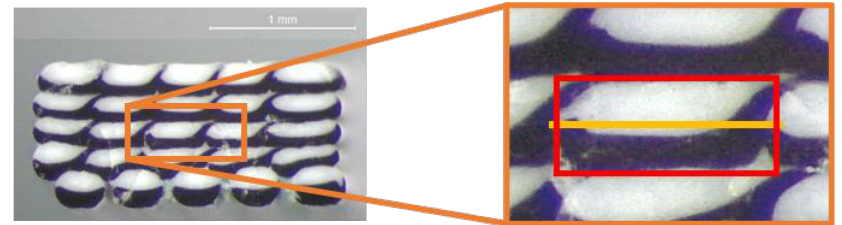
Figure 11. Analysis of the dodecagon section and deposition model superimposition.